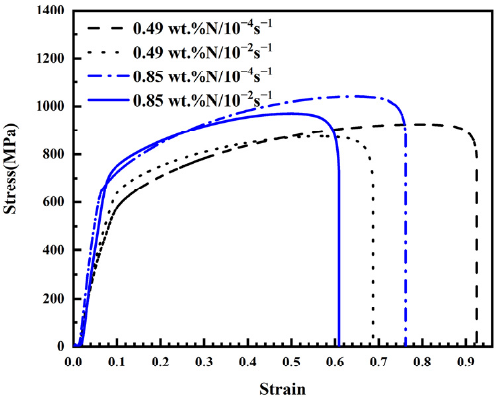
Figure 2. Engineering stress–strain curves of Fe-18Cr-16Mn-2Mo-0.85N and Fe-19Cr-16Mn-2Mo-0.49 N steels at two strain rates of 10 − 4 s − 1 and 10 − 2 s − 1. Table 2. Tensile properties of the tested steels tensioned at two strain rates. Sample